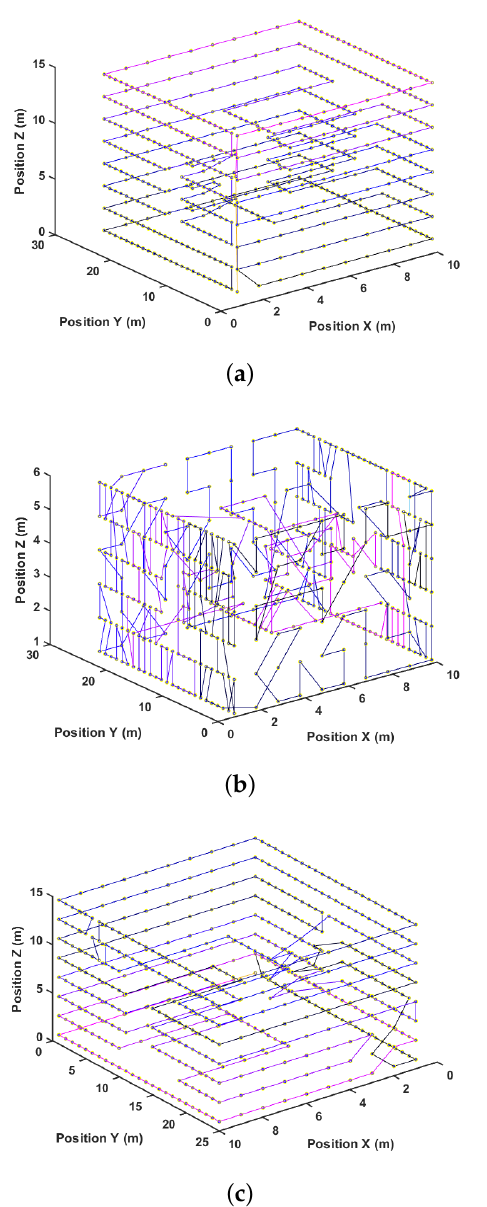
Figure 14. Path after solution for mr. ( a ) Greedy; ( b ) GA; ( c ) 3DD-CPP. Note that the method captures the symmetries and finds an optimal path with a higher computational cost. It is also important to highlight that a fixed cost matrix was used to allow the Greedy Search and GA to present similar results. In real applications, the cost matrix would be calculated using the model in Section 2.3, Energy Cost Estimation. This means that these results are optimized for travel distance. However, energy consumption could be used only by using the proper cost